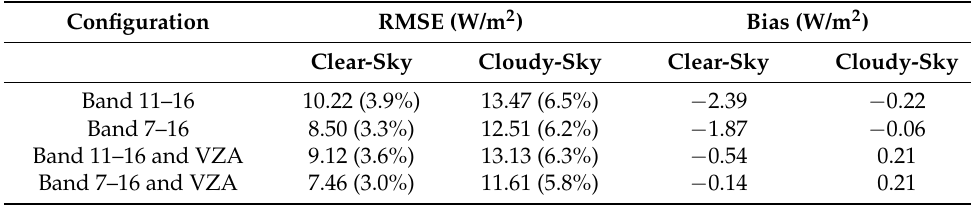
Table 2. Statistics of the test results with different model input configurations.